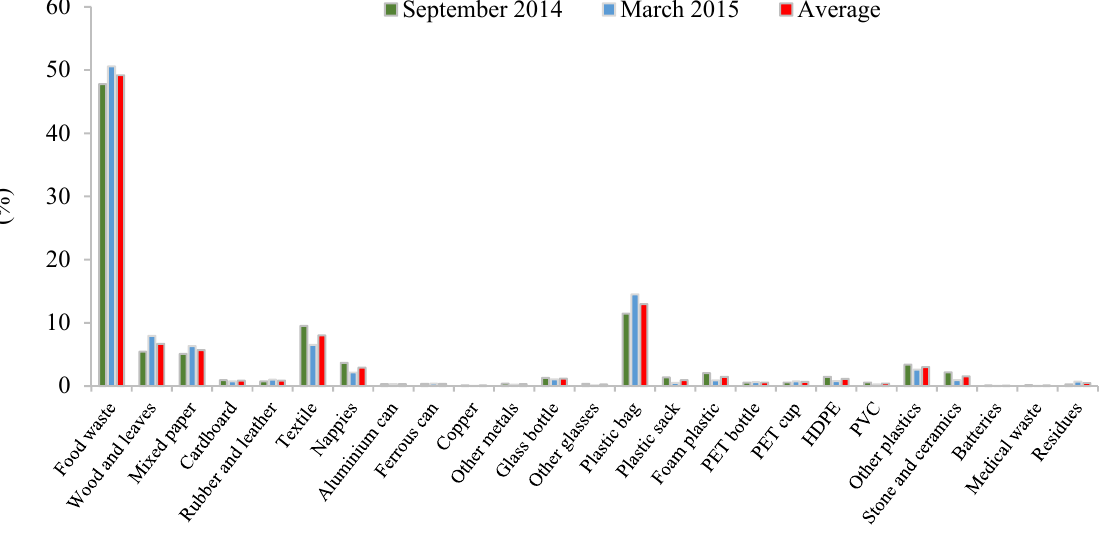
Fig. 3: Sub-compositions of municipal solid waste (% of wet